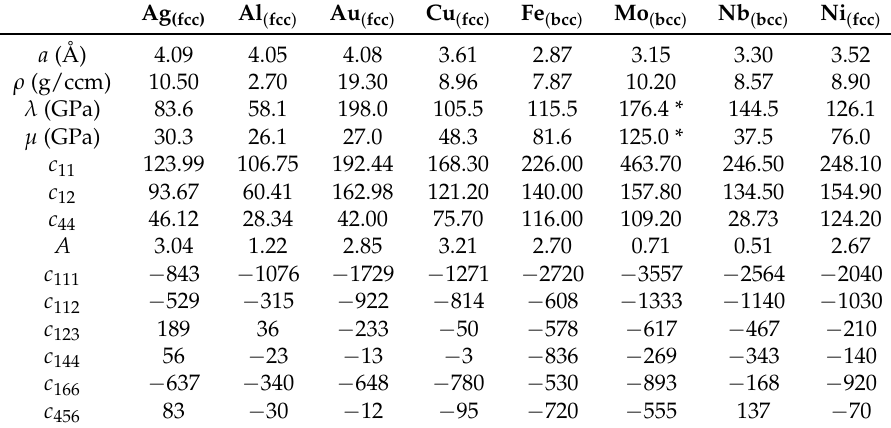
Table 1. List of input data for cubic crystals used in the calculation of the drag coefficient; all elastic constants are given in units of GPa. The references we used to compile these data are: Ref. [35] (Section 12) (lattice parameters a and densities ρ ), Refs. [36] (p. 10) and [37] (effective Lamé constants of the polycrystal except for Mo), Ref. [35] (Section 12) (single crystal SOEC and Zener anisotropy ratio A : = 2 c 44 / ( c 11 − c 12 ) ), and Refs. [38–43] (TOEC). The Lamé constants of Mo (marked with *) are analytical averages of the single crystal SOEC (see, e.g., [34]). The conventions for the single crystal elastic constants are those of Brugger [44].